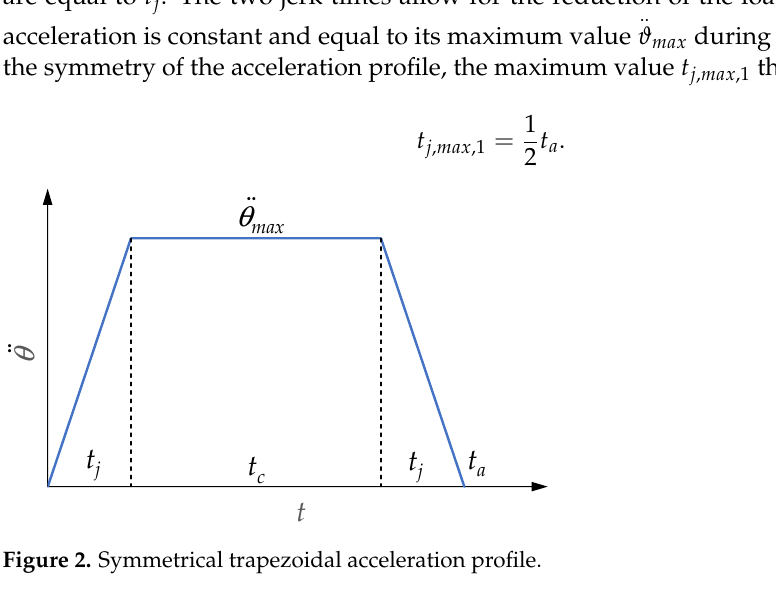
 t . In the same figure, a generic STAP is versus j